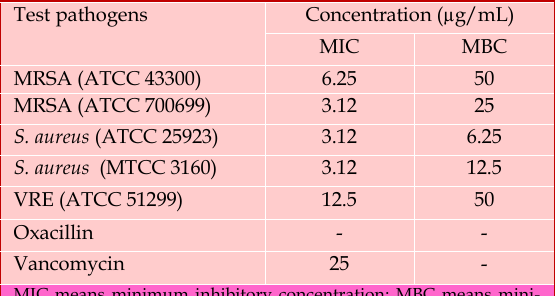
Minimum inhibitory and minimum bactericidal concentration of PTR3 ethyl acetate